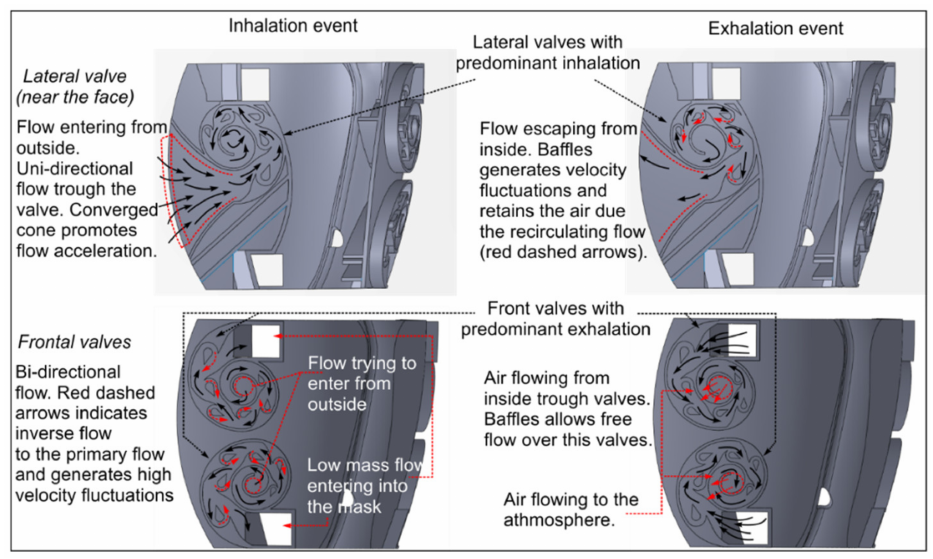
Figure 3. Description of the valves for inhalation and exhalation events.